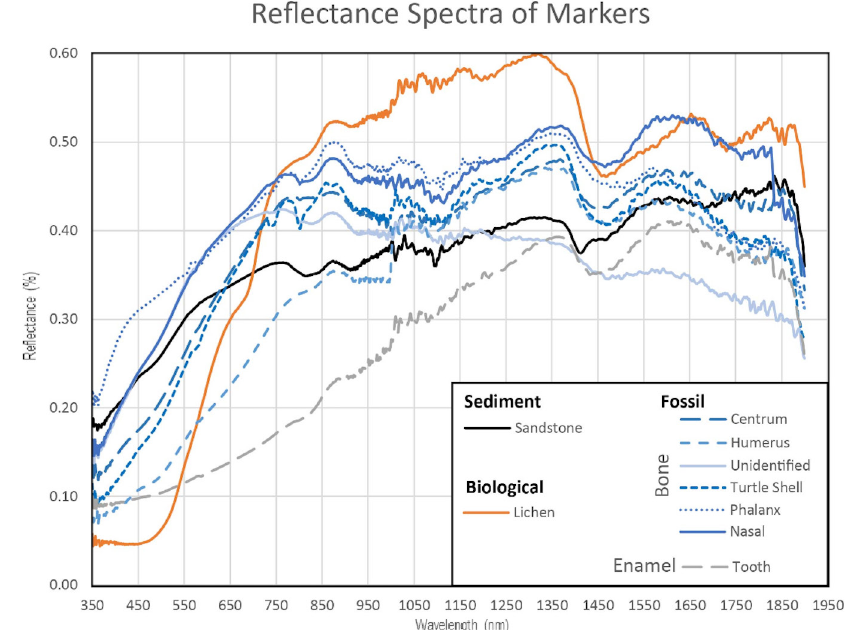
Figure 3. Reflectance spectra of markers from the Dinosaur Park